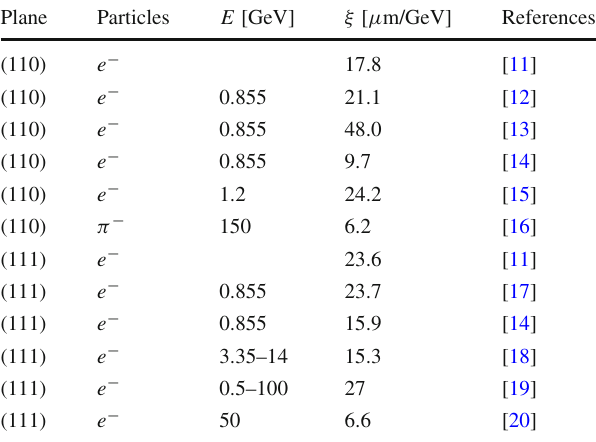
Table 1 Values of the coefficient of proportionality between the dechanneling length and the energy of the charged particles Plane